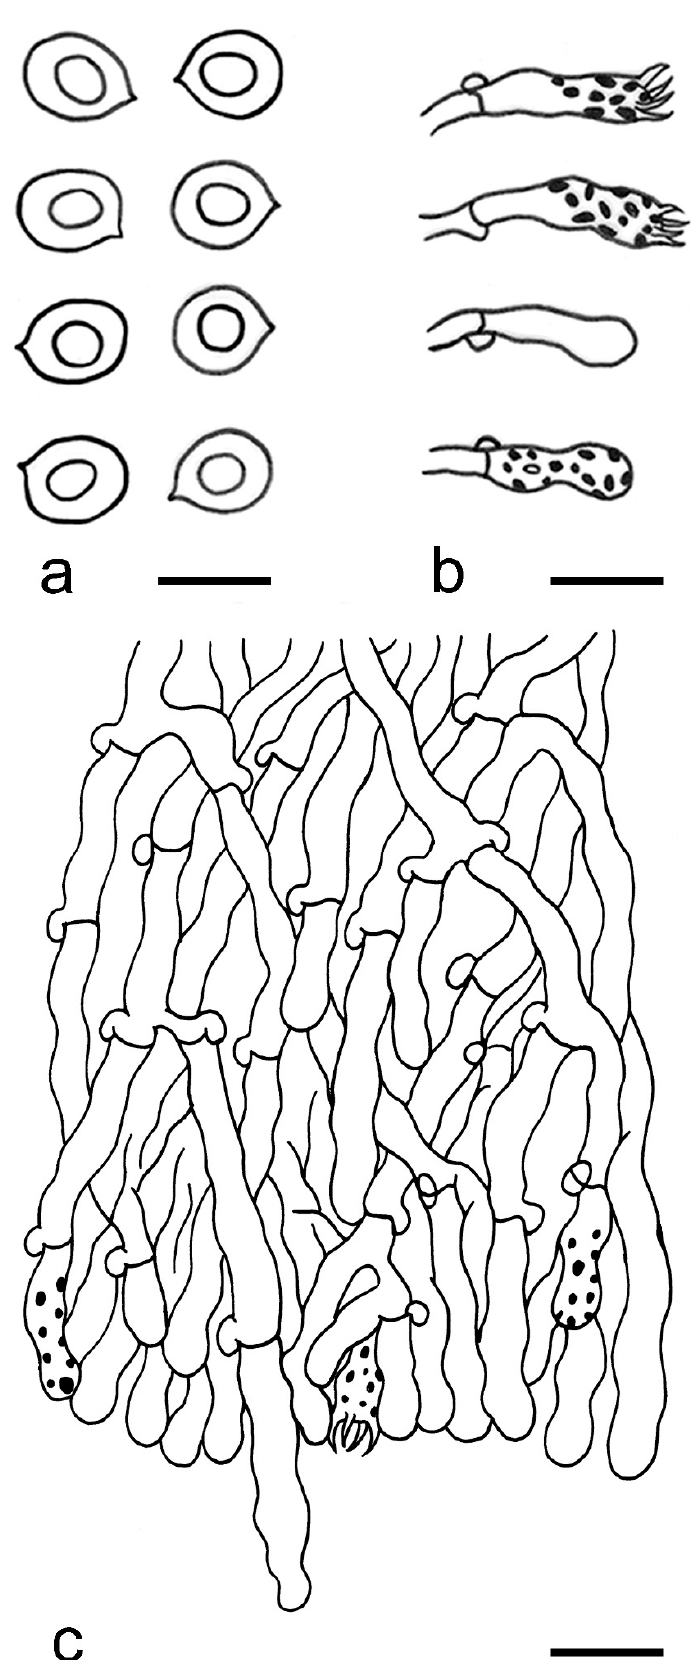
Figure 15. Microscopic structures of Lyomyces elaeidicola (drawn from the holotype). ( a ) Basidiospores; ( b ) basidia and basidioles; ( c ) a section of the basidiocarp.—Scale bars: a = 5 μ m; b , c = 10 μ m.